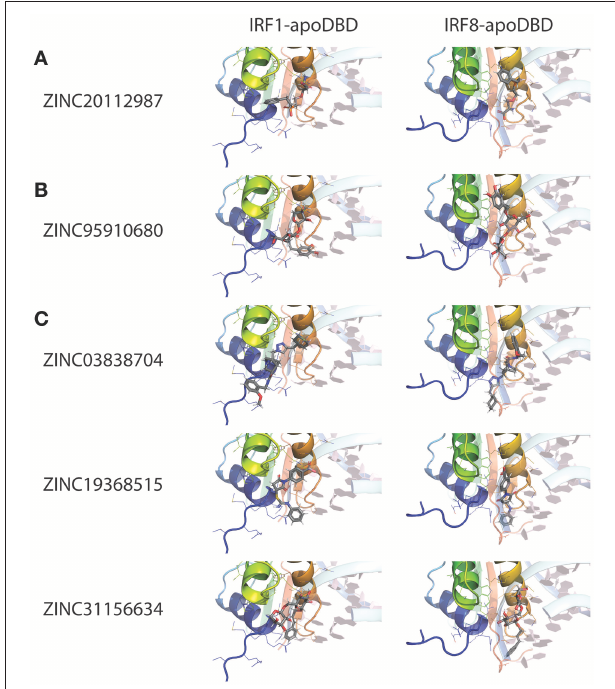
FIGURE 4 | Binding conformations of pre-selected compounds from Natural Products ZINC database subset in different IRF DNA-binding domains. (A) Top-scored IRF1-specific binding compounds in apo-DBD of IRF1 and IRF8; (B) Top-scored IRF8-specific binding compounds in apo-DBD of IRF1 and IRF8; (C) Top-scored pan-IRF1/8 binding compounds in apo-DBD of IRF1 and IRF8. Graphical representation, that has been used, describes in detail binding mode of top-scored conformation of the inhibitor in the active pocket of apoIRF-DBD. dsDNA fragment of the respective holoIRF-DBD/IRE complexes superimposed on the apo-form implicates the position of selected target cavity for inhibitory compound. The best binding conformation of each potential inhibitor is shown in stick representation (carbon—gray; oxygen—red; nitrogen—blue; phosphorus—orange and hydrogen—white). IRF1 and IRF8 apo-DBDs are in the cartoon representation with visible secondary structure, multi-colored with amino acid side chains that interact with compounds shown as lines. dsDNA fragment of the respective IRF-holo-DBD/IRE complexes is shown in 60%-transparent cartoon representation and colored in pale-cyan with nucleobases colored in light-pink. Ligand docking results were obtained using Surflex-Dock 2.6